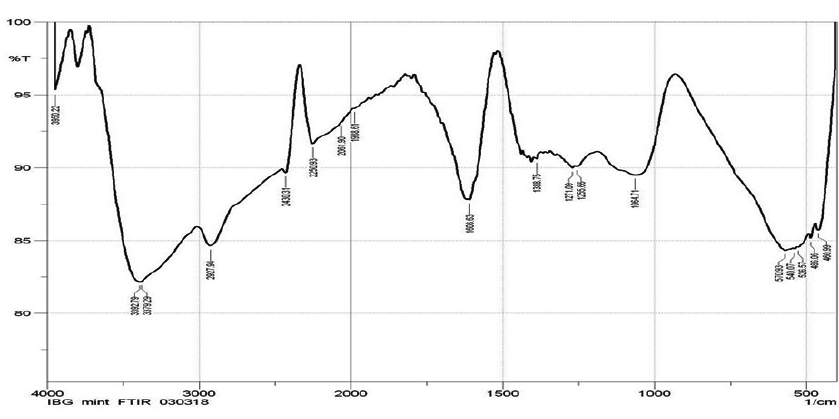
Fig. 1.2. FT-IR Analysis of Plectranthus amboinicus aqueous extract